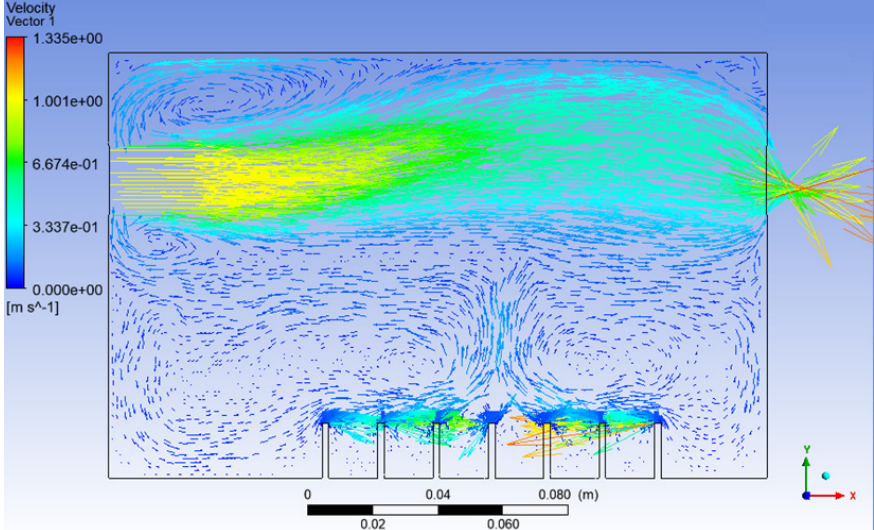
Figure 10. Velocity vector of Simulation 3.